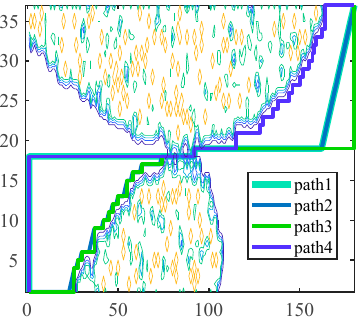
Figure 22. Collision-free paths founded by the MDPF algorithm in the map with the dangerous potential field for case 1.